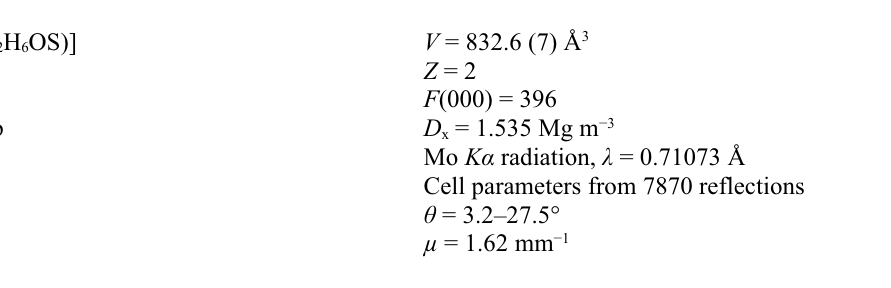
A partial packing view, showing the one-dimensional chain structure. H atoms have been omitted for clarity. catena -Poly[[(dimethyl sulfoxide- κ O)zinc(II)]- µ -(E)-2-[(2-oxido-1-naphthyl)methyleneamino]propanoato- κ 4 O 2 ,N,O 1 :O 1 ′